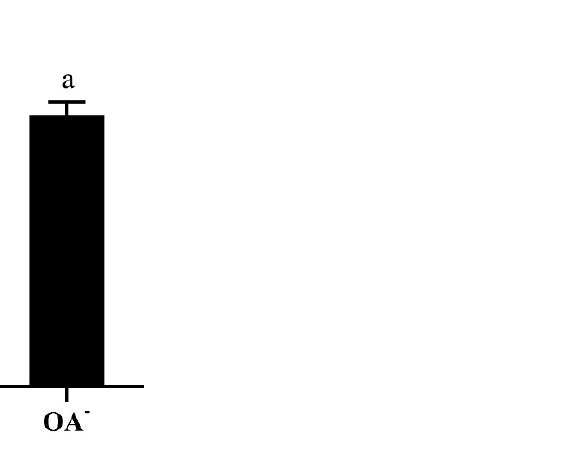
Figure 5. Growth of the S. latifolia mycelium in PSM. ( a ) Growth of the S. latifolia mycelium in PSM supplemented with 10 mM OA; ( b ) growth of the S. latifolia mycelium in PSM; ( c ) growth of the S. latifolia mycelium in PSM supplemented with 4 mM OA - .